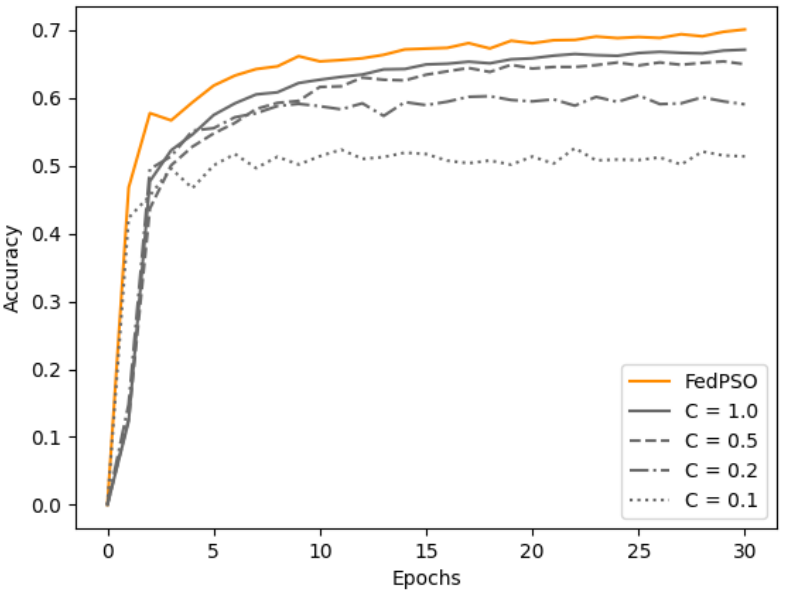
Figure 4. Accuracy comparison of several algorithm.